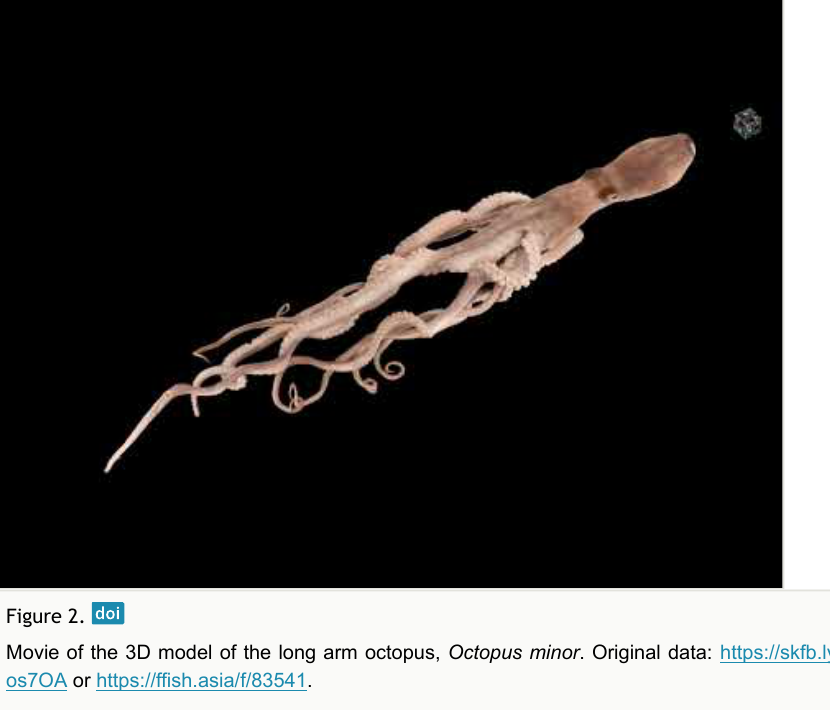
Movie of the 3D model of the long arm octopus, Octopus minor . Original data: https://skfb.ly/ os7OA or